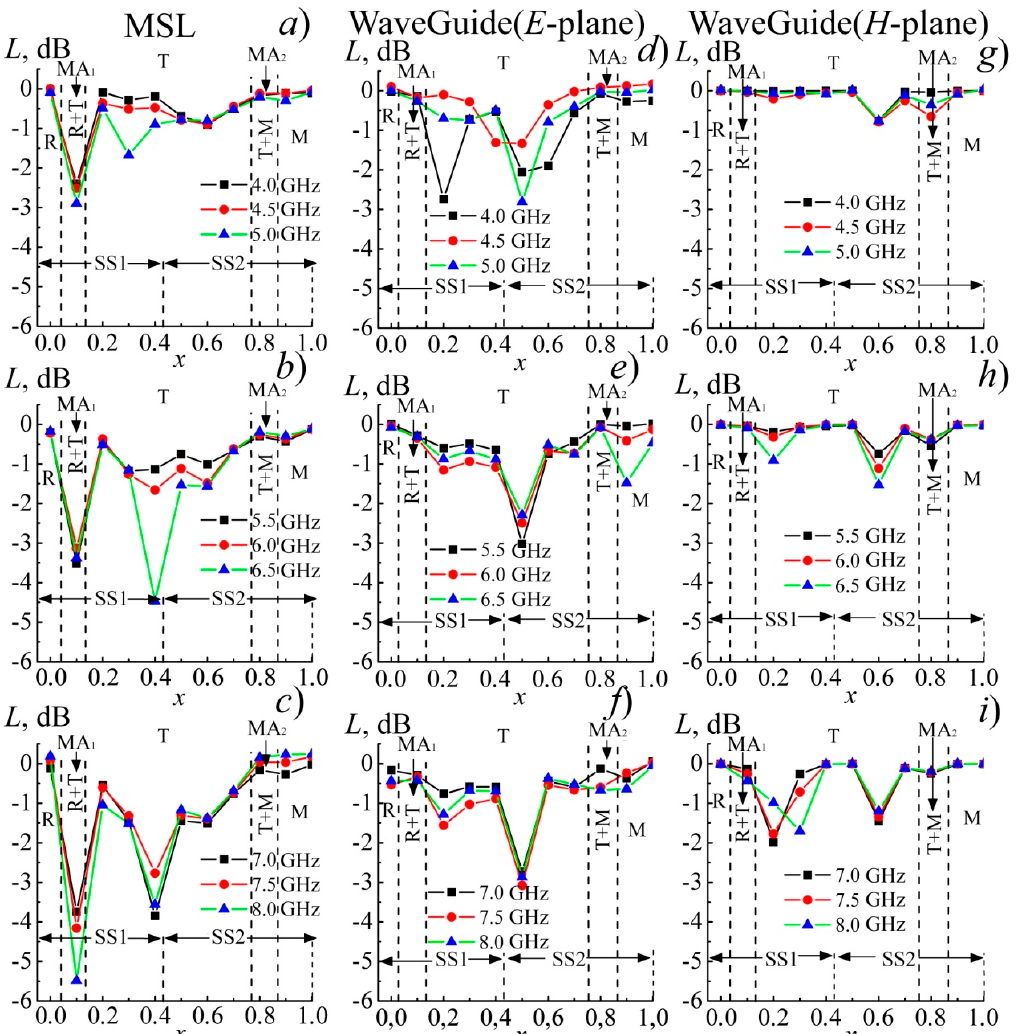
Figure 8. Dependences of L ( x ) with superposition of the phase diagram of the system. (MSL ( a – c ), waveguide line in the E-plane ( d – f ) and H-plane ( g – i )).